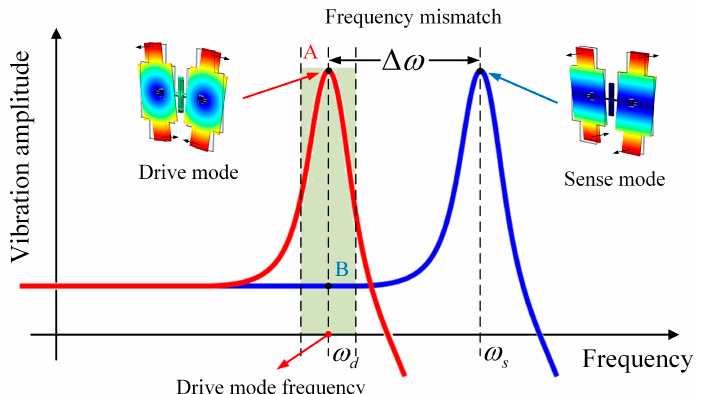
Figure 3. The frequency mismatch about the drive mode and the sense mode of the BFVG.